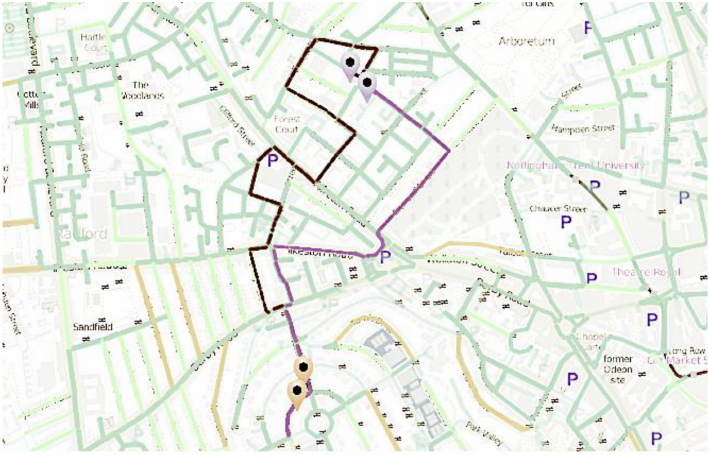
Figure 12. The fastest (dark) and eco-friendly (light) route recommendation in the city of